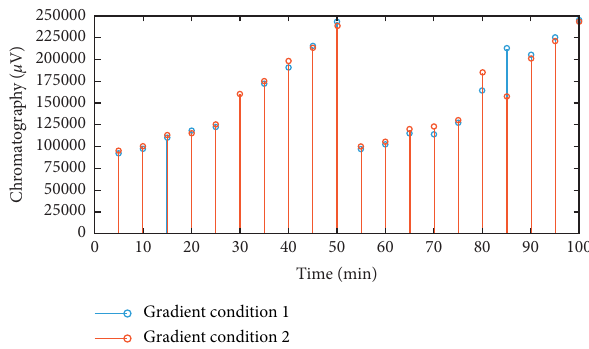
Figure 4: Comparison of chromatograms under two gradient